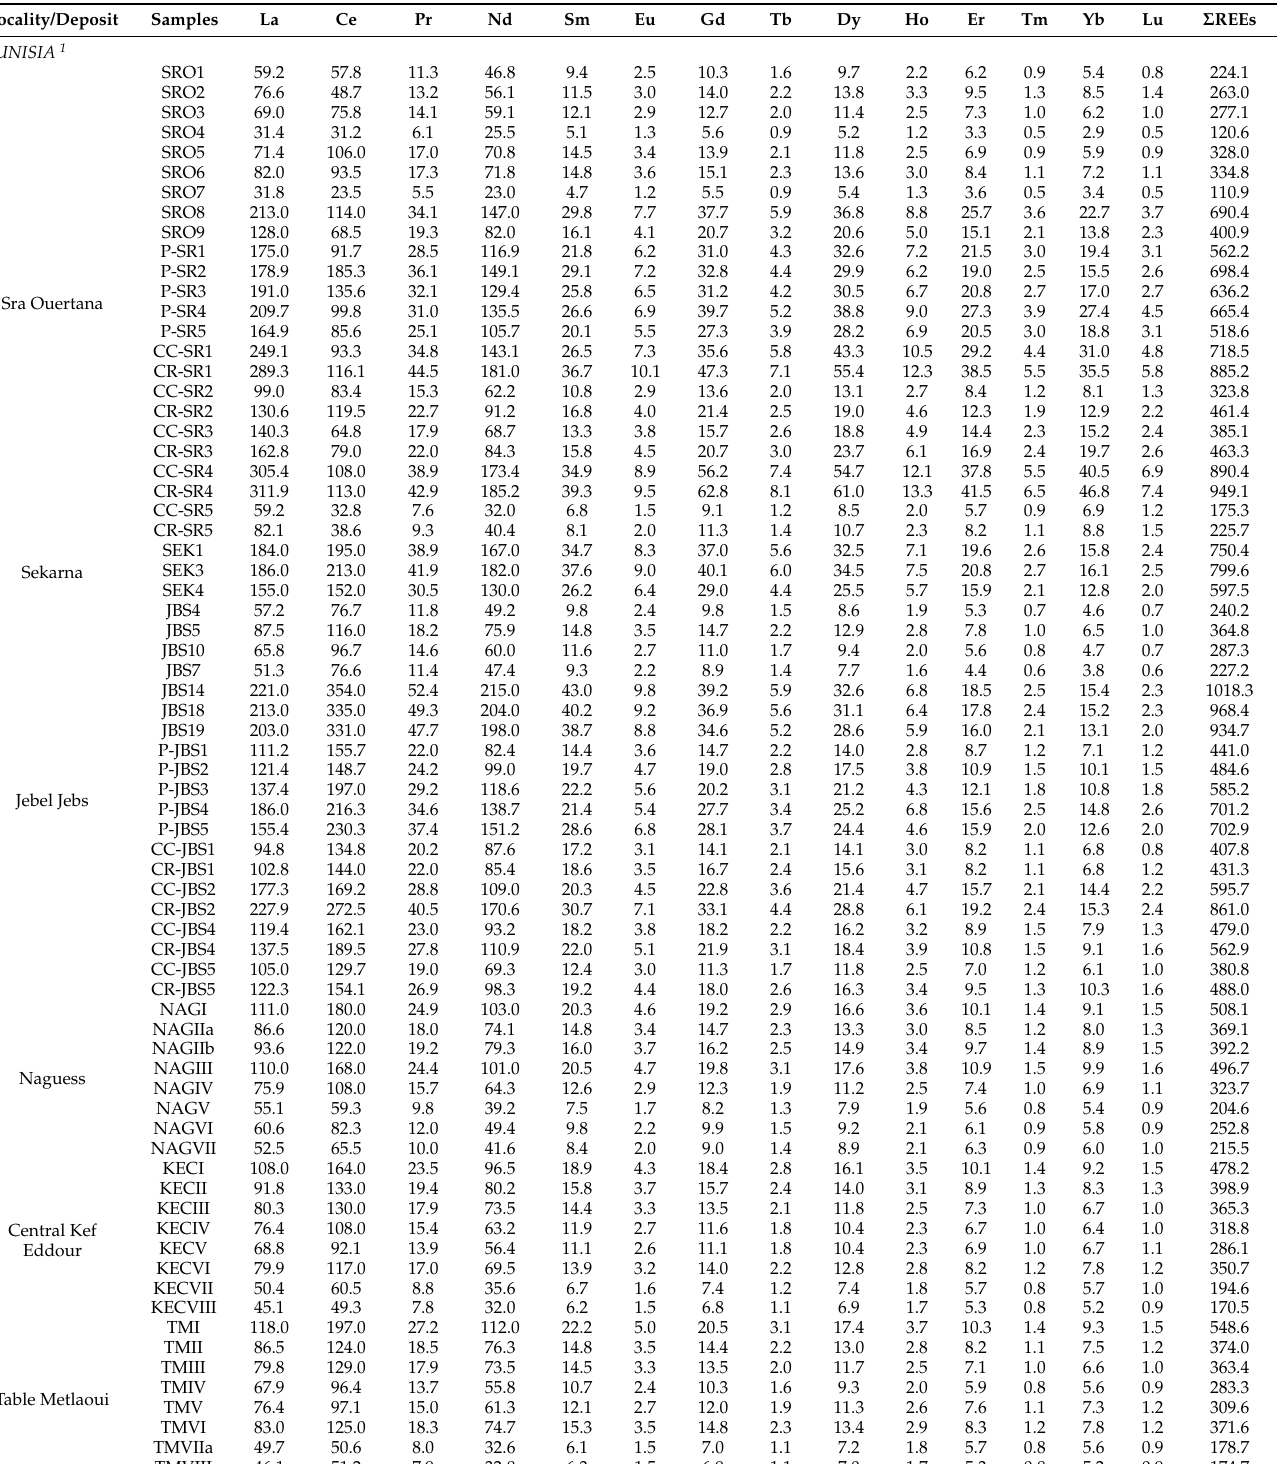
Table 2. Rare earth elements composition (ppm) of all the Northern African phosphorite deposits studied in this paper. See Supplementary Material for the ages of each deposit/sample and values of the Ce and Eu anomalies, and (La/Yb) ch and (Gd/Yb) ch